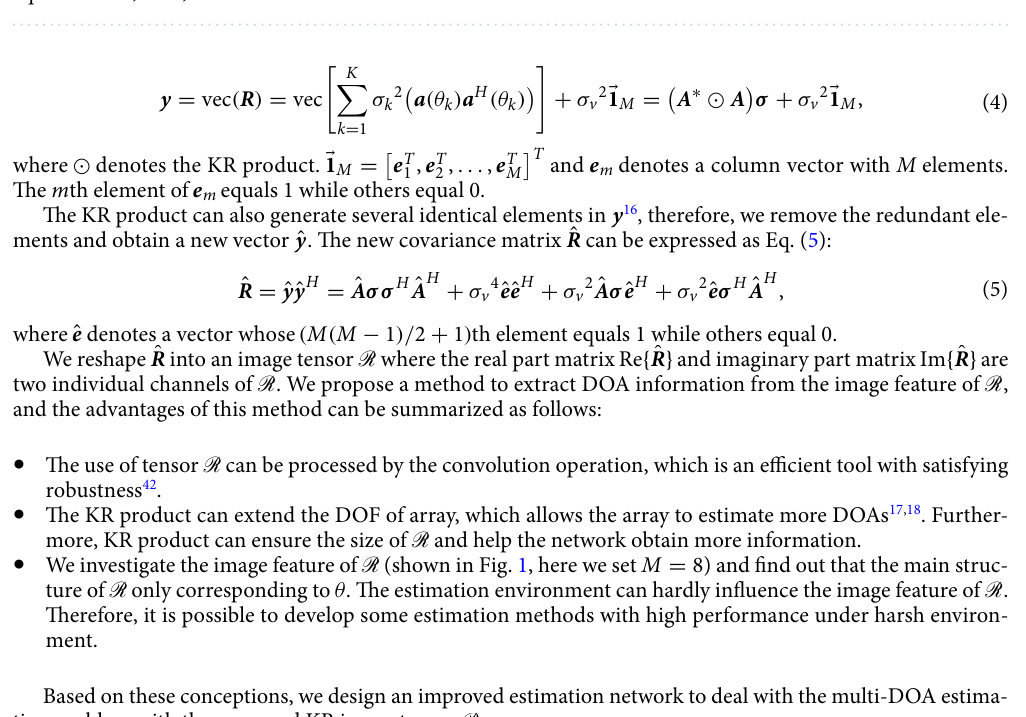
Figure 1. Image feature of matrix Re {ˆ R } . From top to bottom, θ = 20 ◦ , 40 ◦ , and 60 ◦ . From left to right, the SNR equals − 5 dB, 0 dB, and 5